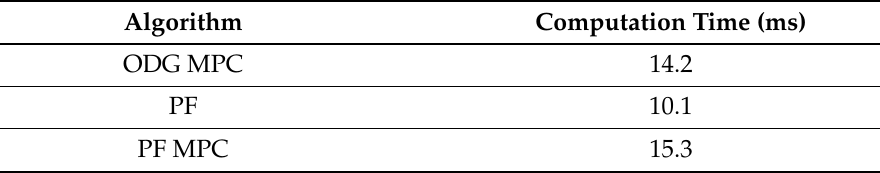
Figure 18. Results of the path for Scenario 1. Table 4. Results of the computation time.